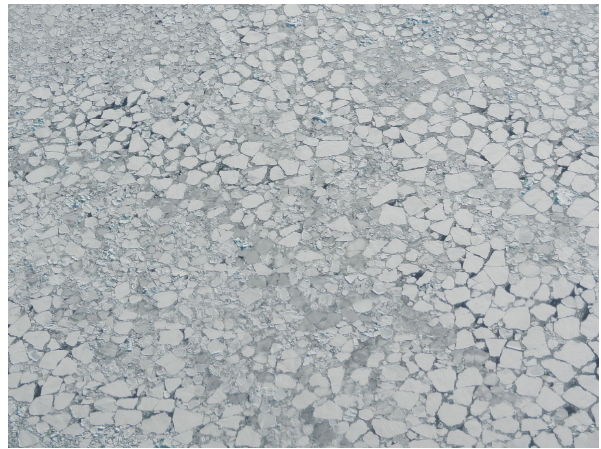
Figure 20: Image of naturally broken sea-ice floes, taken outside Ny-˚Alesund May 9, 2011.